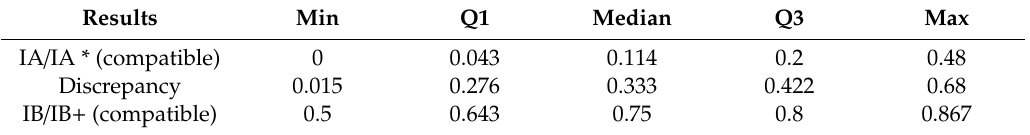
Table 4. Results of radiologists′ diagnoses and pathological stages.